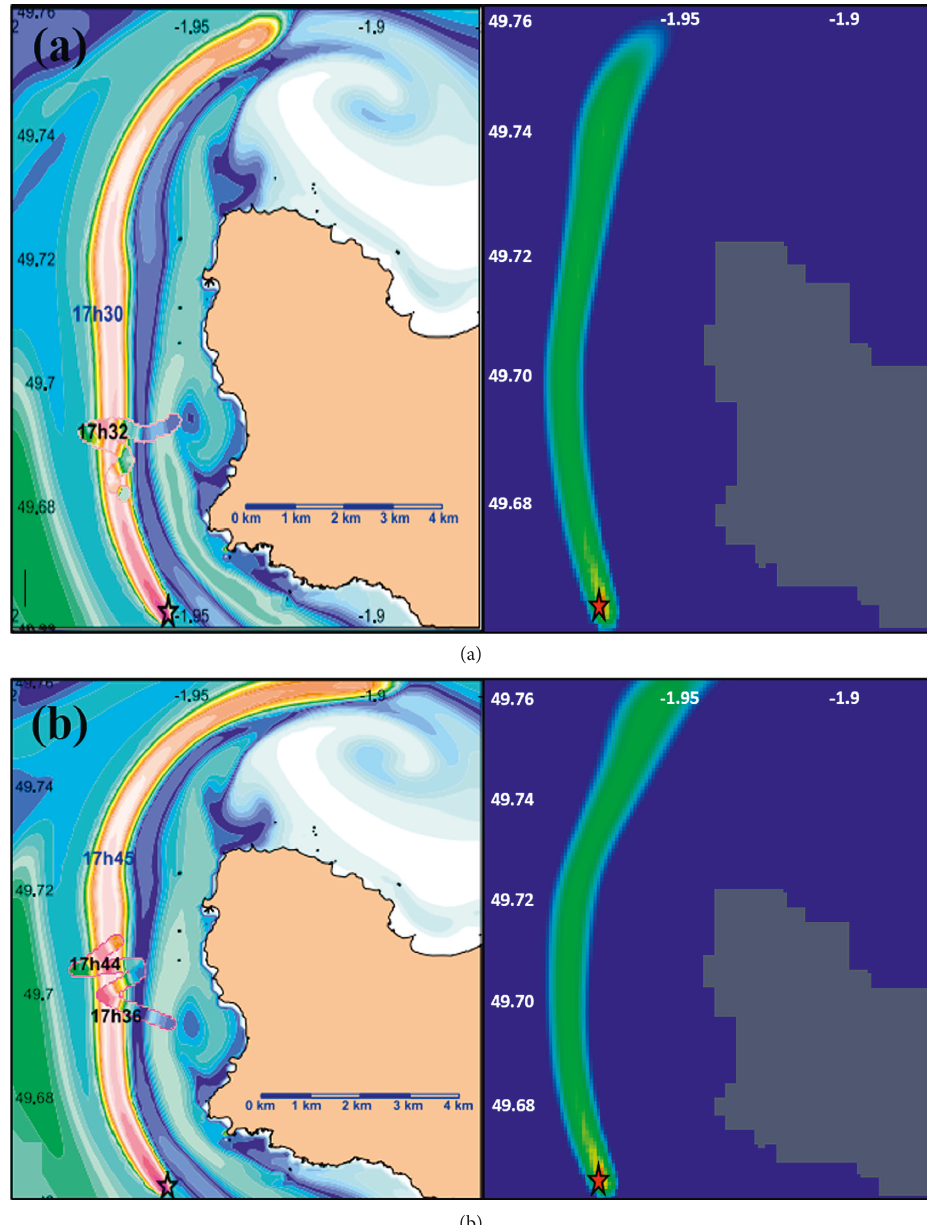
Figure 4: Tritium dispersion in the vicinity of Cap de La Hague. (a) t � 17h 30. (b) t � 17h